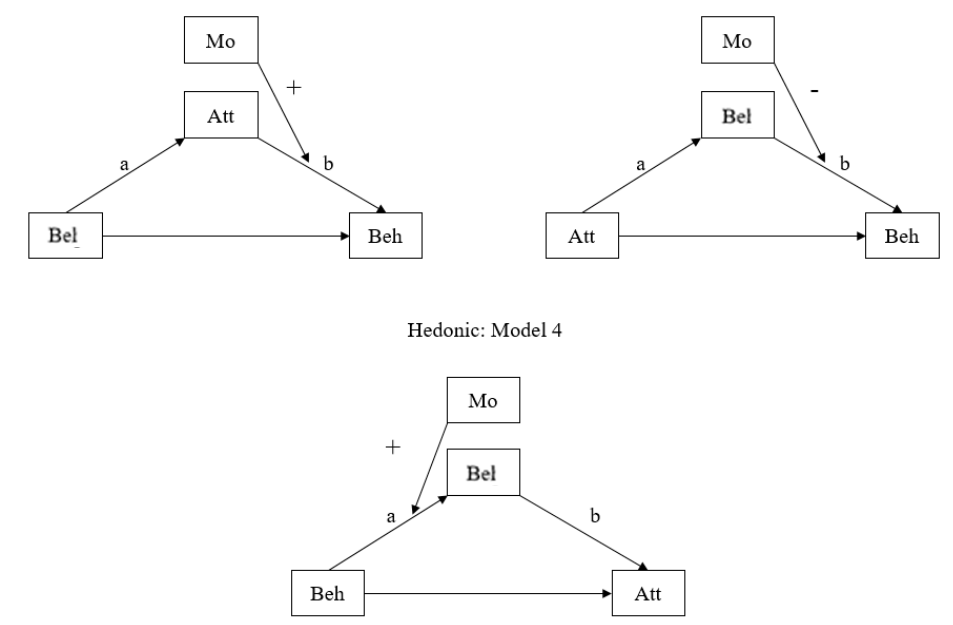
Figure 6. Government Trust Model in Korea.